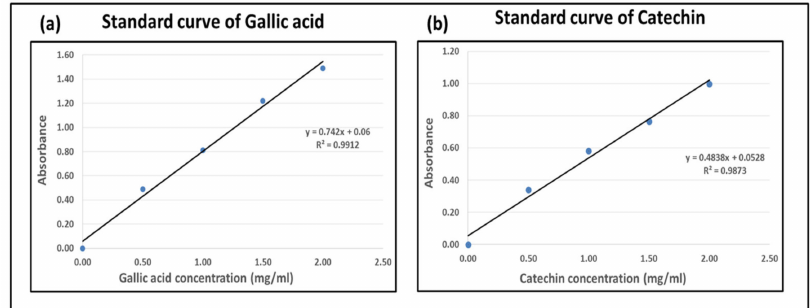
Figure 1. Standard curves: ( a ) gallic acid, ( b )